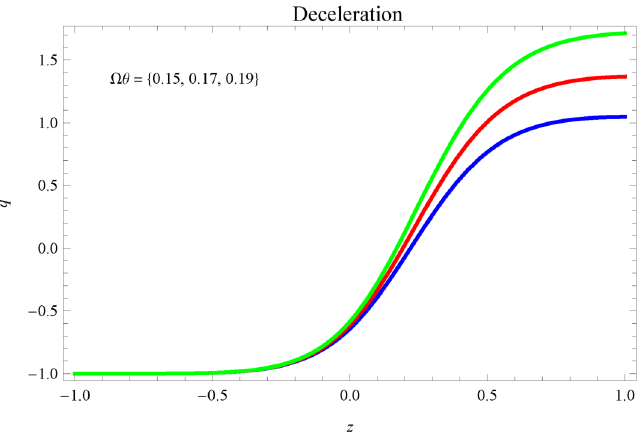
Figure 1. q versus z